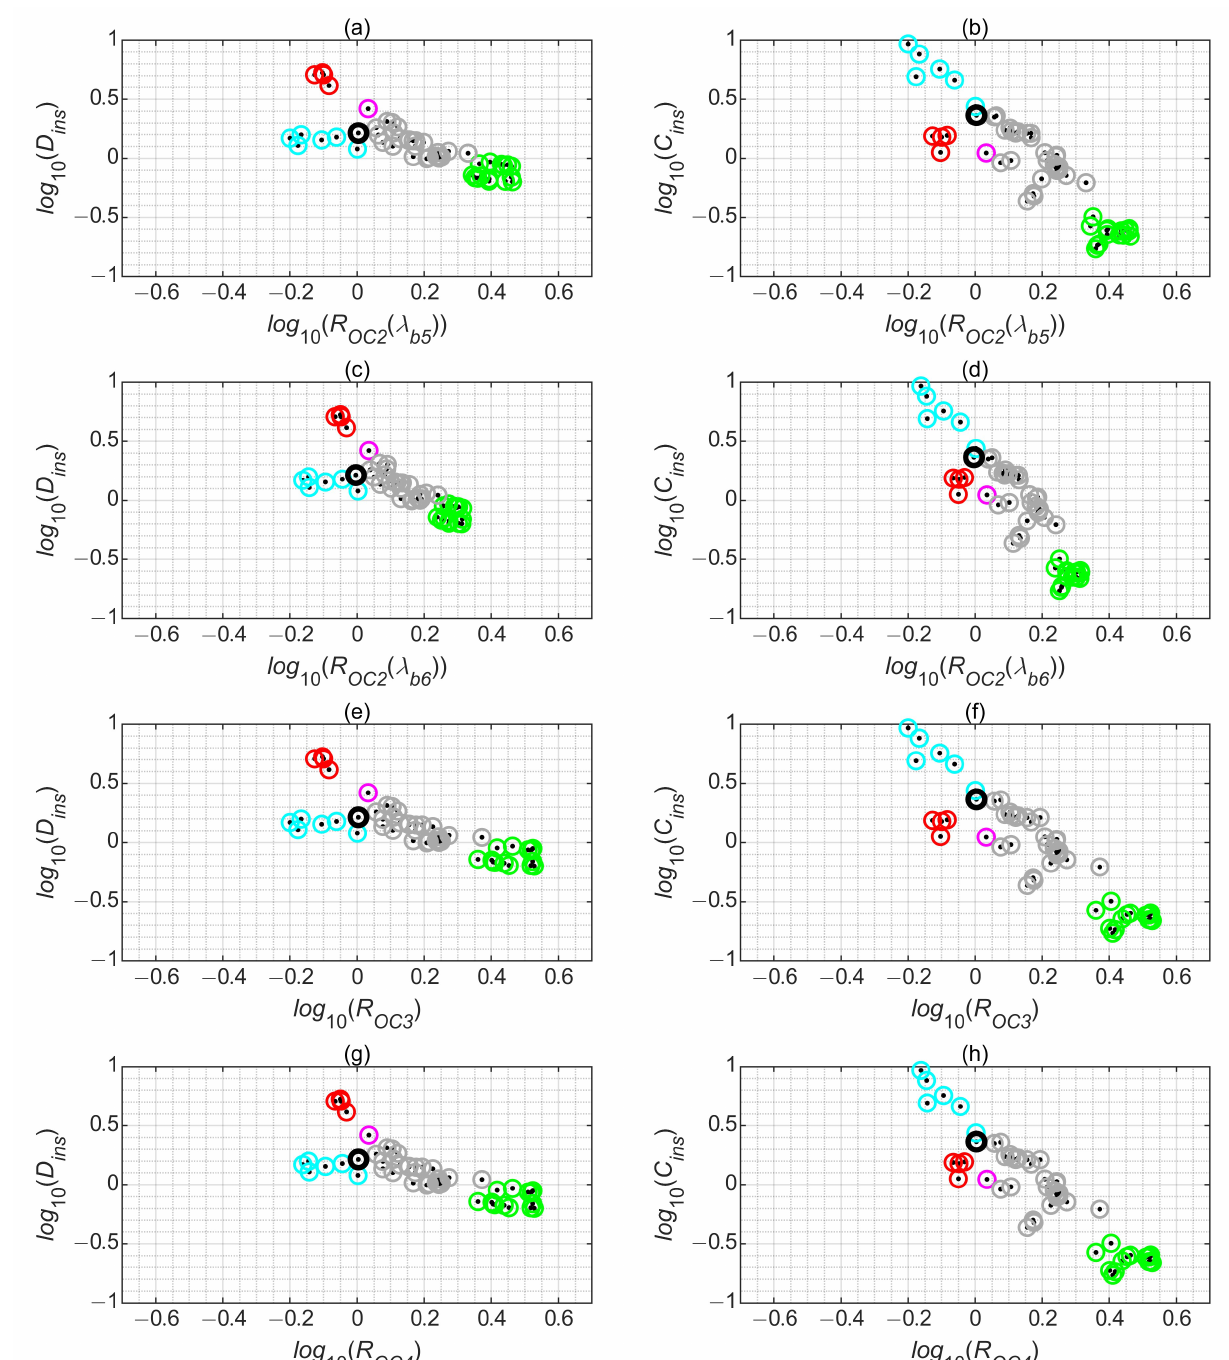
Figure 9. Scatterplots of the logarithms of in situ CDOM content ( D ins ) ( a , c , e , g ) or chl-a concentrations ( C ins ) ( b , d , f , h )versus R OC 2 band ratio index for the b5 ( a , b ) and b6 ( c , d ) spectral ranges and versus R OC 3 ( e , f ) and R OC 4 ( g , h ). Band ratio values were obtained by applying OLCI/S3A spectral response functions to shipborne hyperspectral measurements collected using an ASD